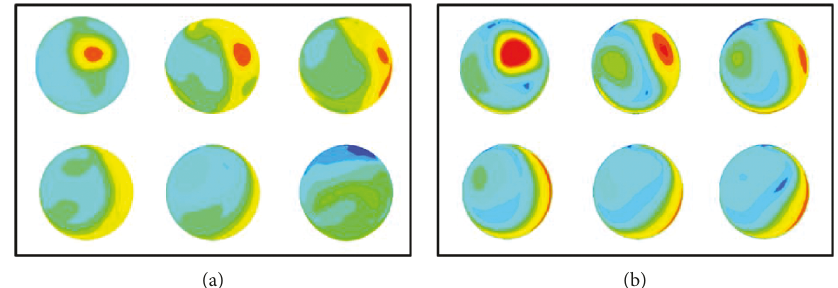
Figure 10: Contour of liquid phase fraction (a) and velocity (b). (The six figures in each part represent sections (4), (5), and (6) in the first row and (7), (8), and (9) in the second row from left to right.).